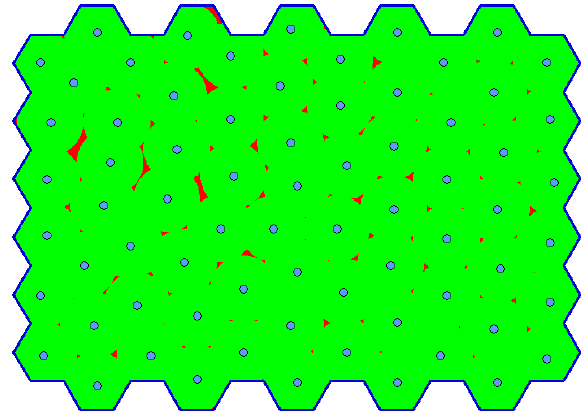
Figure 12. The best solution found for instance d06.